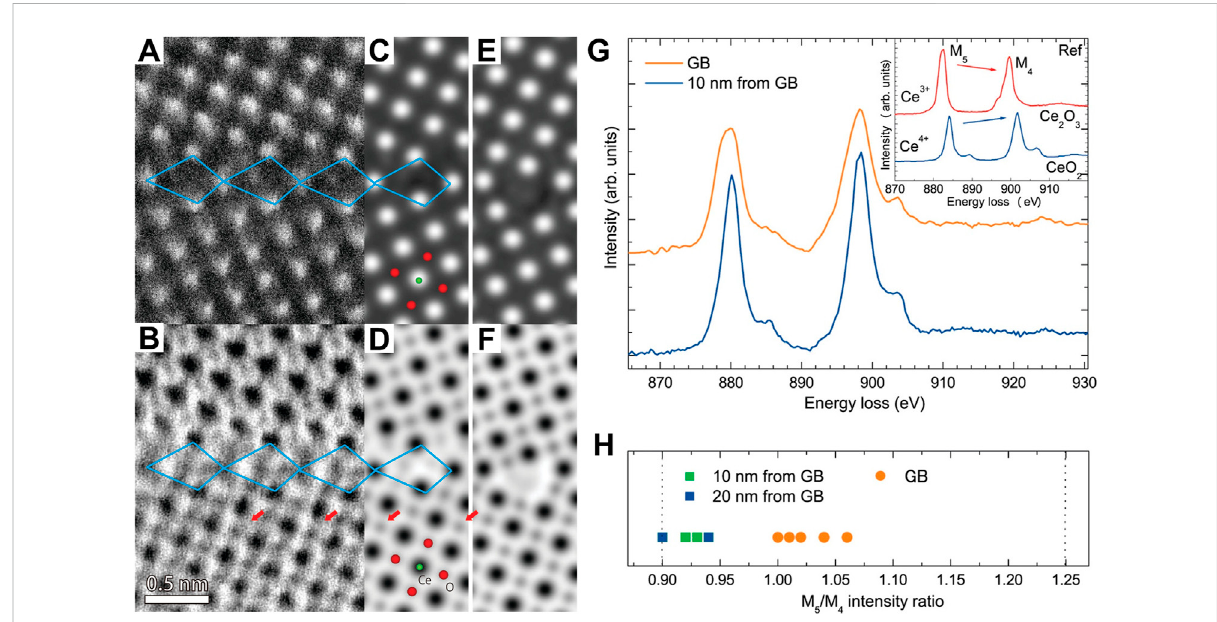
FIGURE 5 AtomicstructureofaCeO 2 grainboundary: (A,B) HAADF (A) andABF (B) imagesofa(210) Σ 5grainboundaryinaCeO 2 thin fi lm. (C – F) Simulated HAADF and ABF images of the non-stoichiometric (C,D) and stoichiometric (E,F) grain boundary model structure. (G,H) Typical Ce M 4,5 -edge EELS spectra taken from the grain boundary and interior region and variation of the M 5 /M 4 intensity ratio at the two different regions. Reproduced with permission (Hojo et al., 2010), Copyright 2010, American Chemical